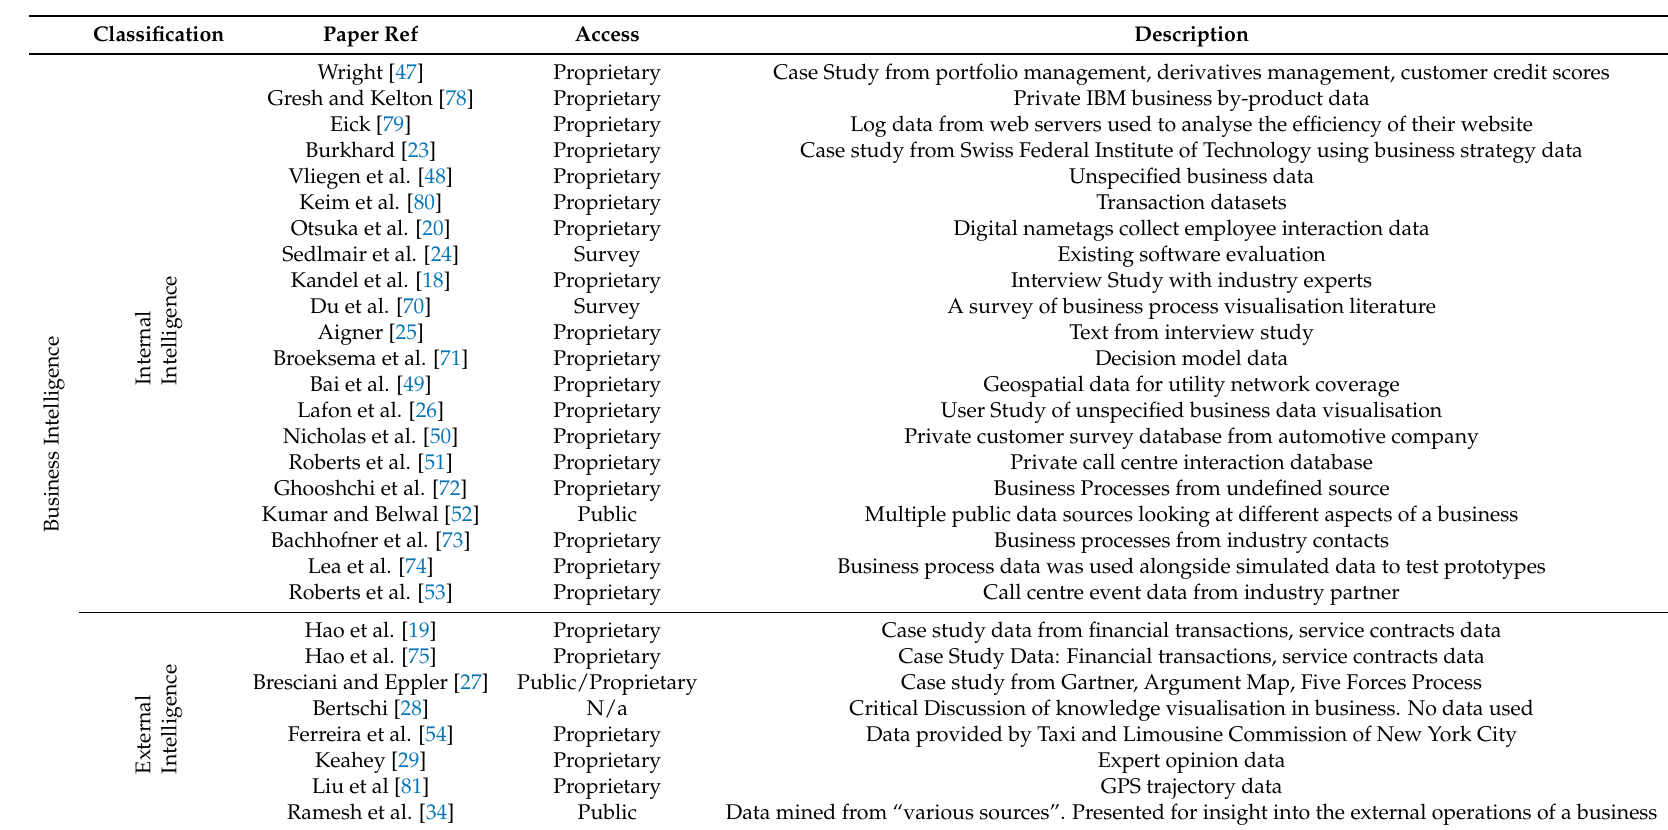
Table 4. This table summarises the data sources in each research paper, identifying the accessibility of the data as well as a brief